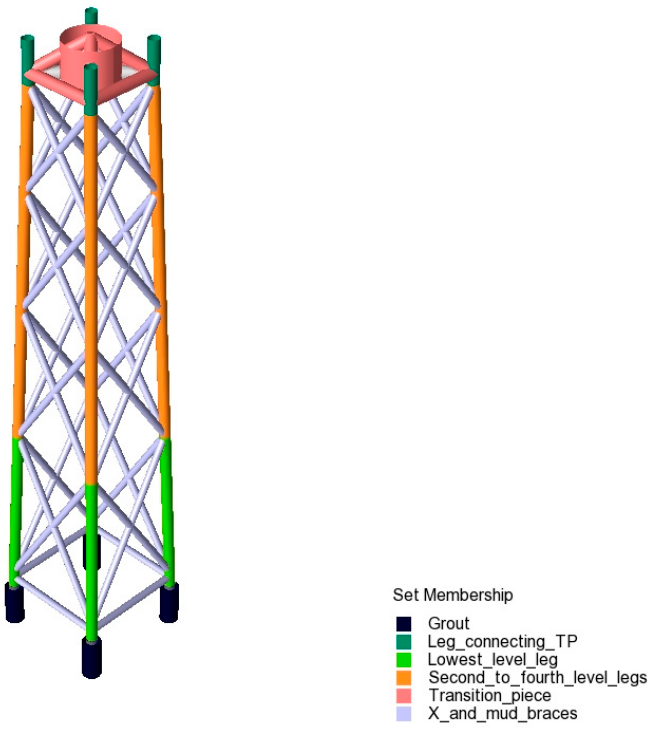
Figure 1. Model of the jacket foundation.